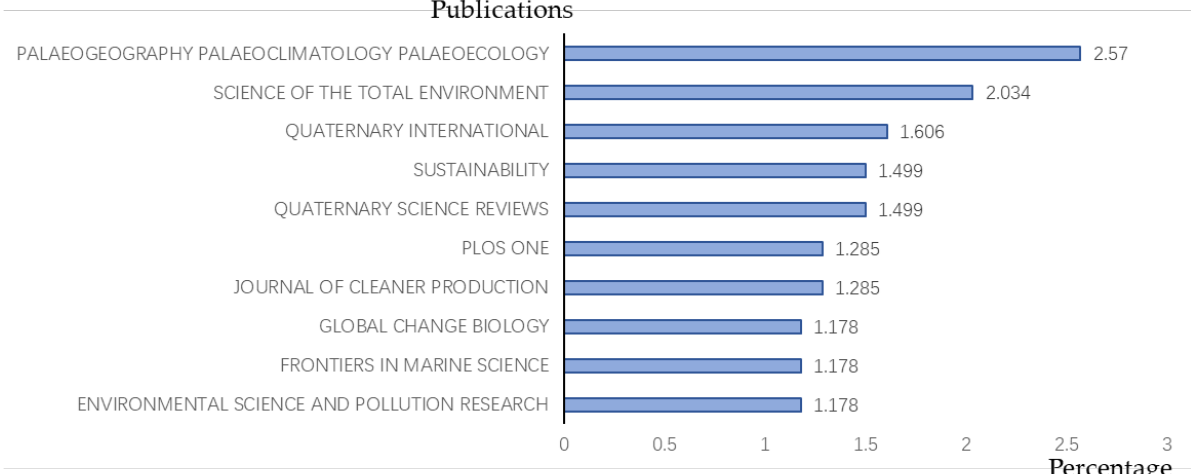
Figure 4. Percentage distribution of the number of articles issued by RCHSCC source publications (top 10).